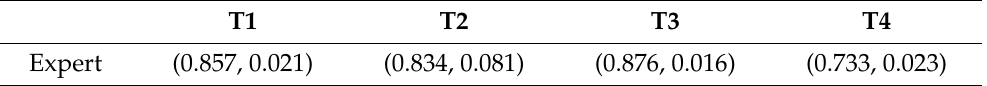
Table 4. The generalization parameters given by the expert for each target.